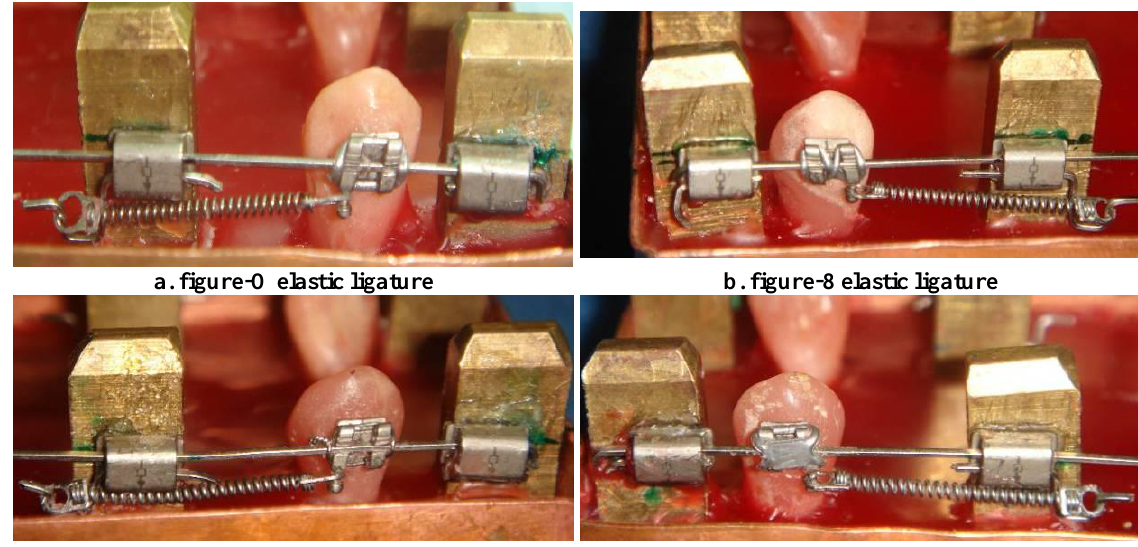
c. stainless steel ligature d. Slide elastic ligature Figure 2: Canine retraction by NiTi closed coil spring for the four groups.